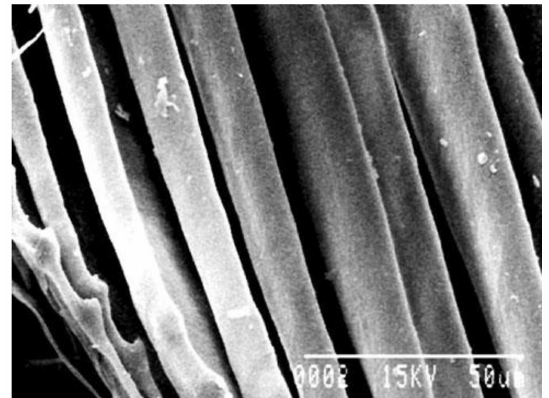
Figure 4. SEM micrograph of HF (magnification: 10,009) [1].